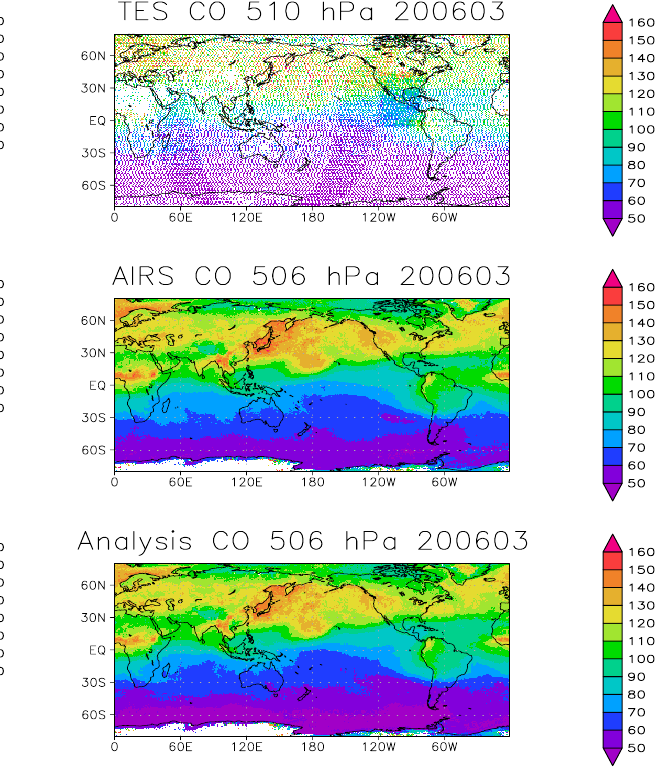
Fig. 6. Grid-averaged monthly mean CO distribution at approximately 944hPa with TES CO (top panel), AIRS V5 CO (middle panel), and analyzed CO (bottom panel).